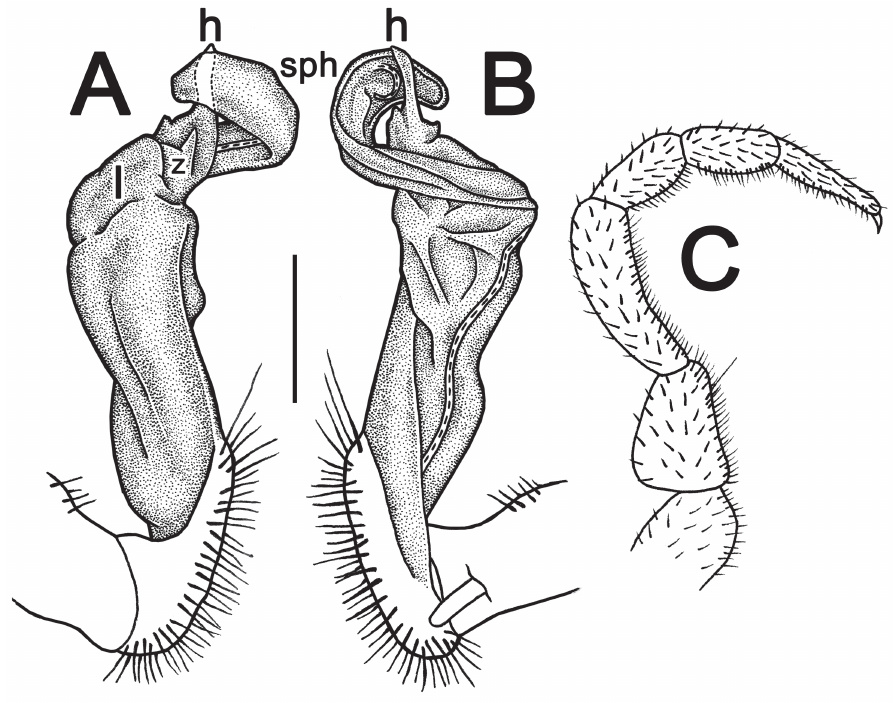
Fig. 13. Tylopus acuminatus sp. nov., holotype, ♂, right gonopod. A–B . Lateral and mesal views, respectively. C . Leg 13. Scale bar: a–B. 0.5 mm; C = no scale bar. Abbreviations are explained in the